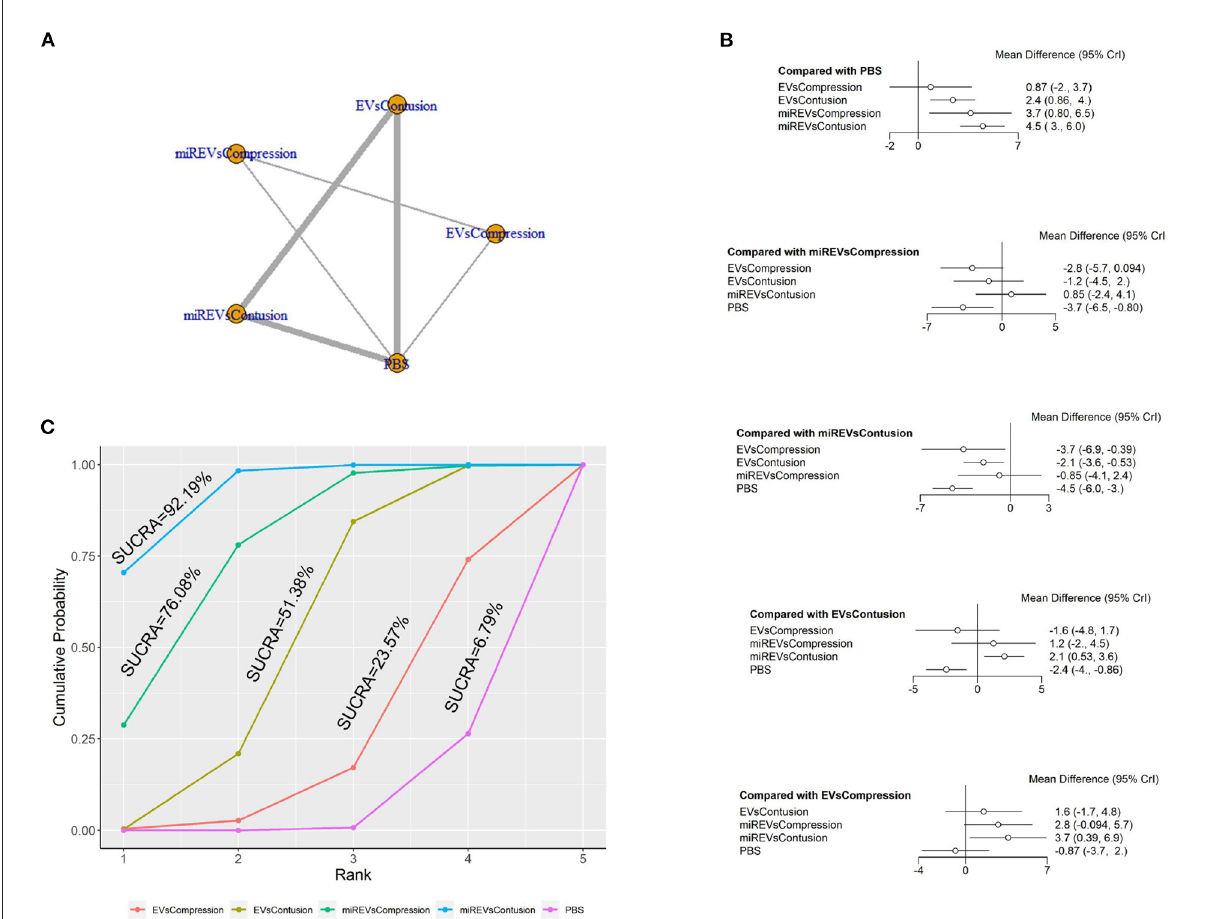
FIGURE8 The network meta-analysis of BBB scores in different models at 14 days after administration. (A) Network plot; (B) Forest plot; (C) SUCRA plot. EVsCompression, EVs in compression models; EVsContusion, EVs in contusion models; miREVsCompression, miRNAs-loaded EVs in compression models; miREVsContusion, miRNAs-loaded EVs in contusion models.